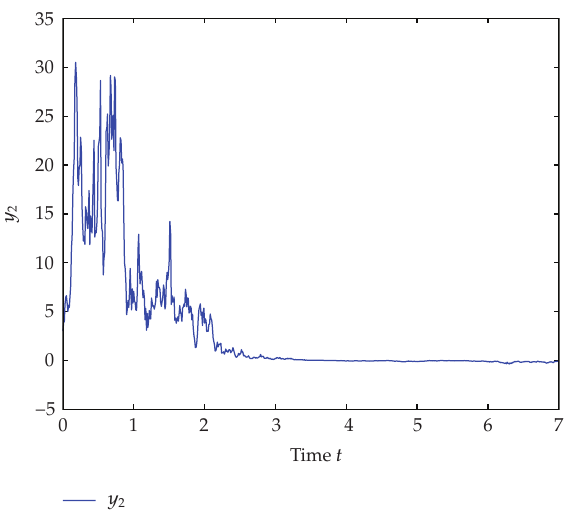
Figure 2: Numerical simulation for y 2 (cid:3) t (cid:4) .